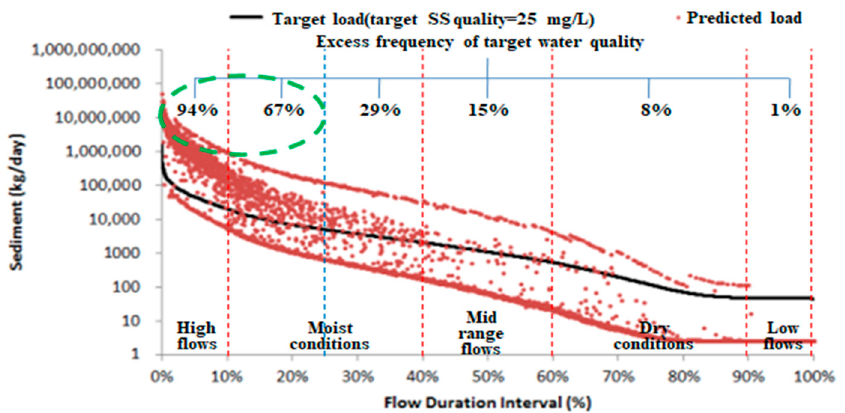
Figure 3. Analysis of the effects of non-point pollution sources.